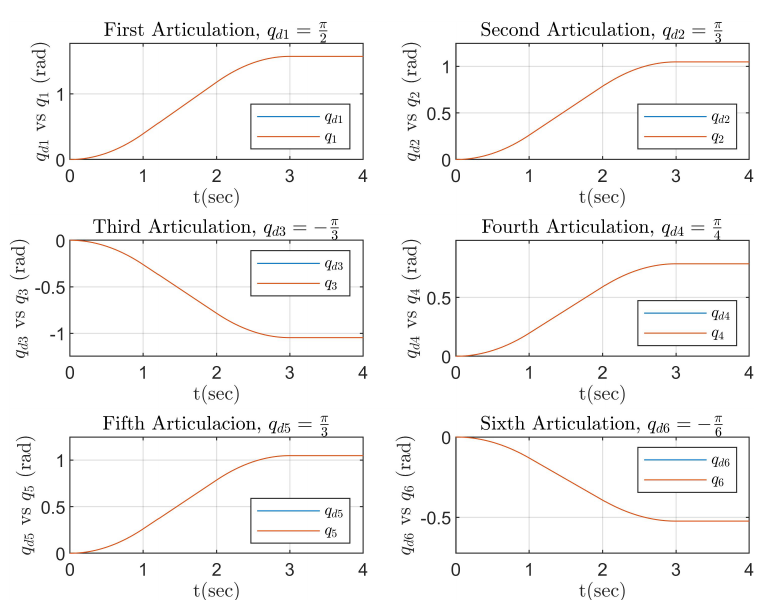
Figure 3. CTC numerical simulation with no